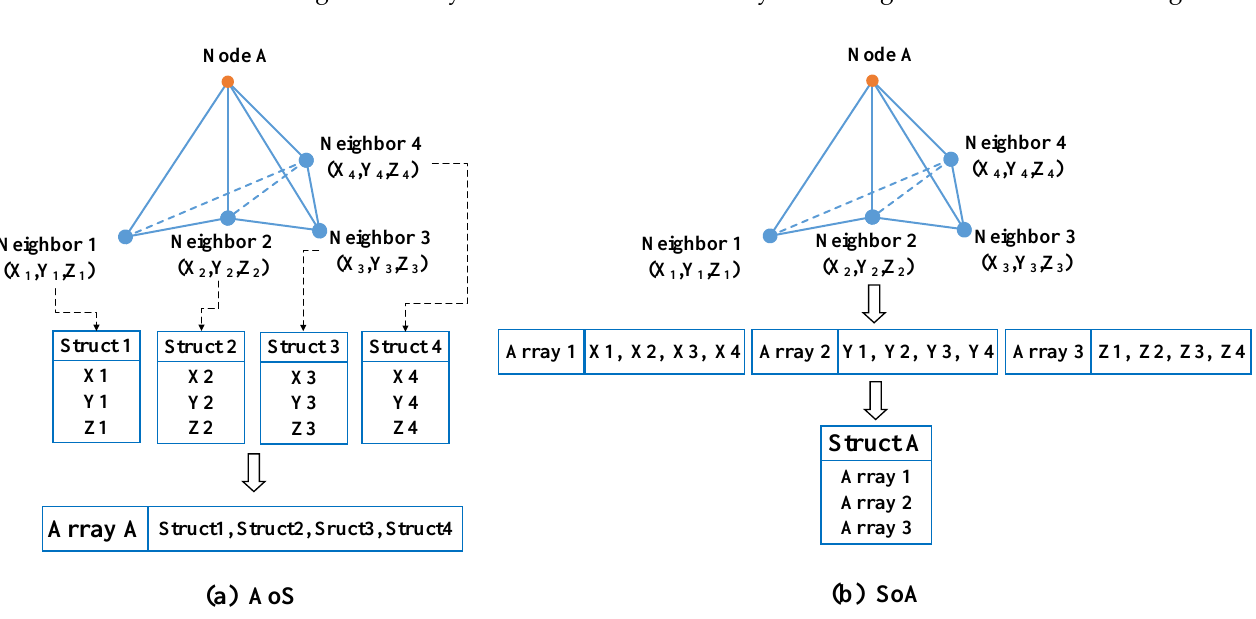
Figure 3. Two common data layouts: AoS and